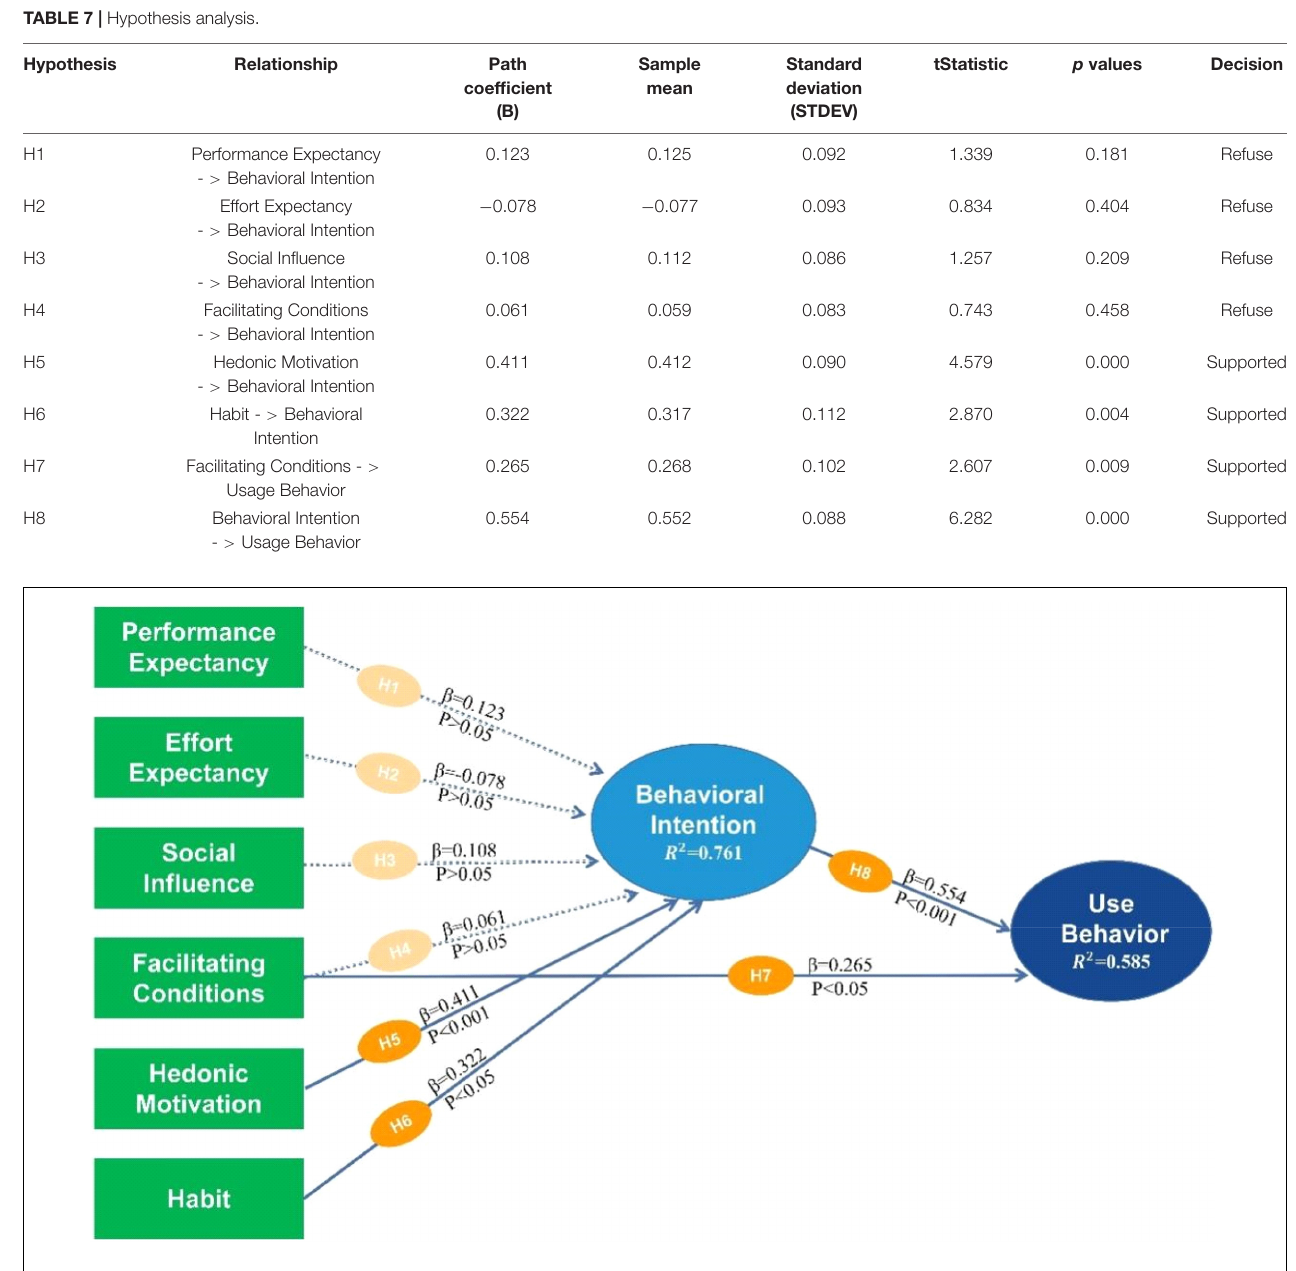
FIGURE 5 | Path coefficient and p